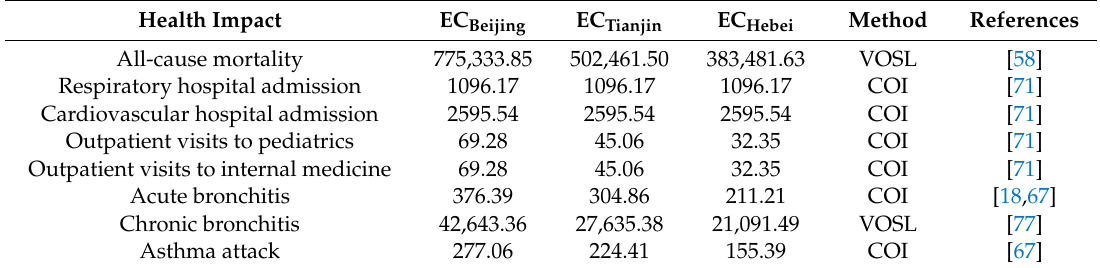
Table 3. Economic costs per case of di ff erent health e ff ects